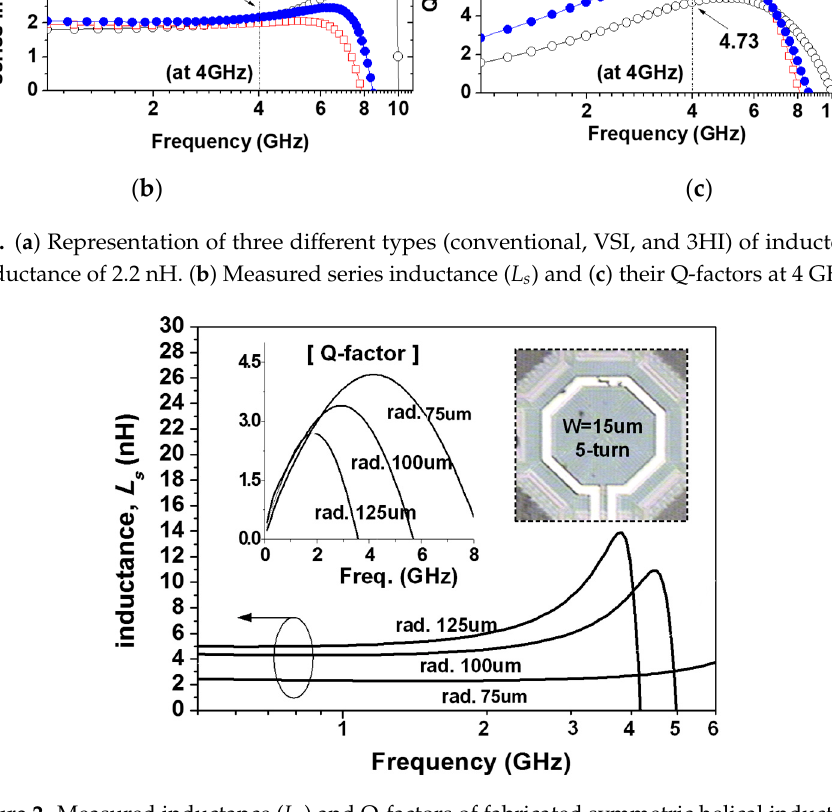
Figure 2. Measured inductance ( L s ) and Q-factors of fabricated symmetric helical inductors.